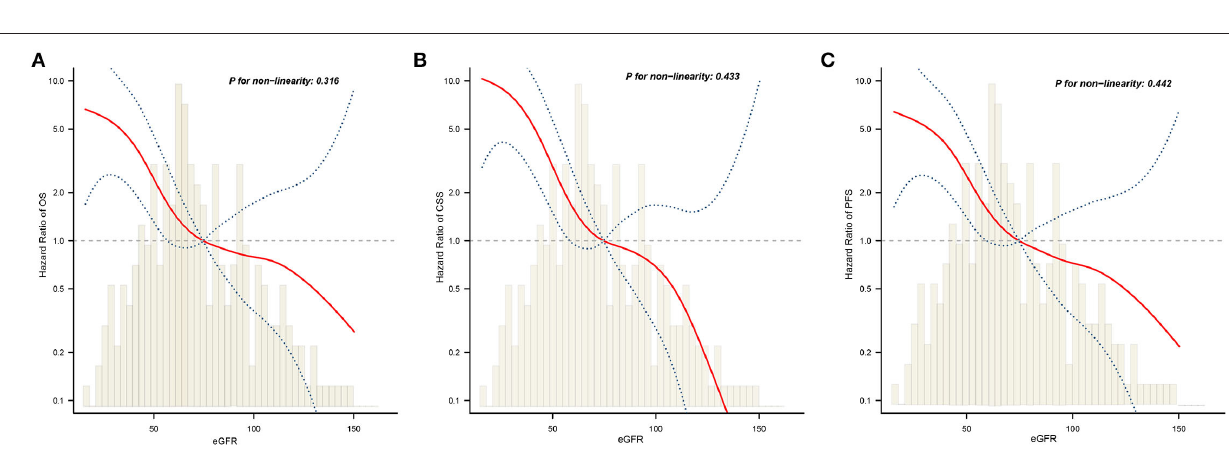
FIGURE 3 | Receiver operating characteristic curves of postoperative eGFR for predicting OS (A) , CSS (B) , PFS (C) in the primary cohort. eGFR, estimated glomerular filtration rate; OS, overall survival; CSS, cancer-specific survival; PFS, progression free survival.